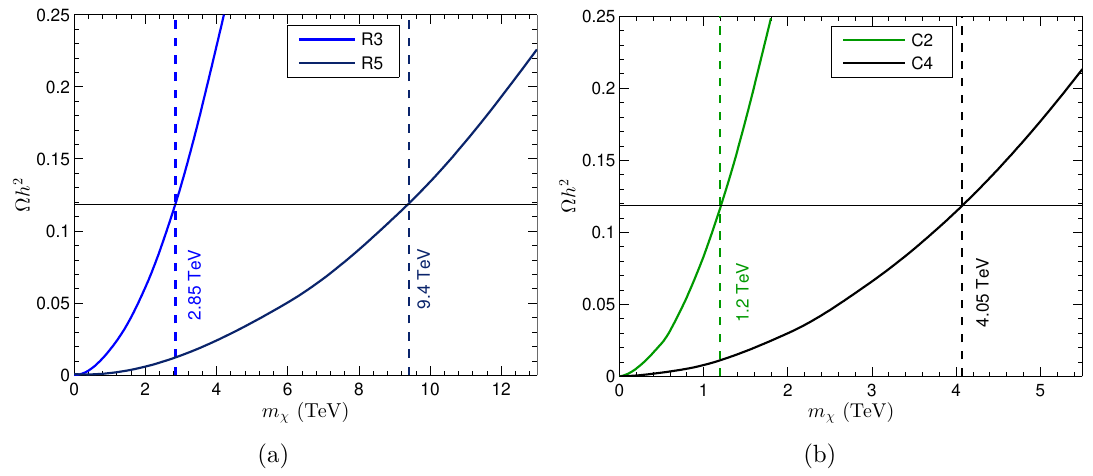
Figure 6. Relic abundance of different EWDM modules which includes real triplet (blue) and quintuplet (navy) in the right panel 6(a) as well as pseudo-real doublet (green) and quartet (black) in the right panel 6(b) versus DM mass. The horizontal line refers to the observed value of dark matter abundance Ω h 2 = 0 . 1188 ± 00010 [3]. EWDM freeze-out mass is the point where this horizontal line crosses the relic curve. This value is shown by a vertical dashed line for each